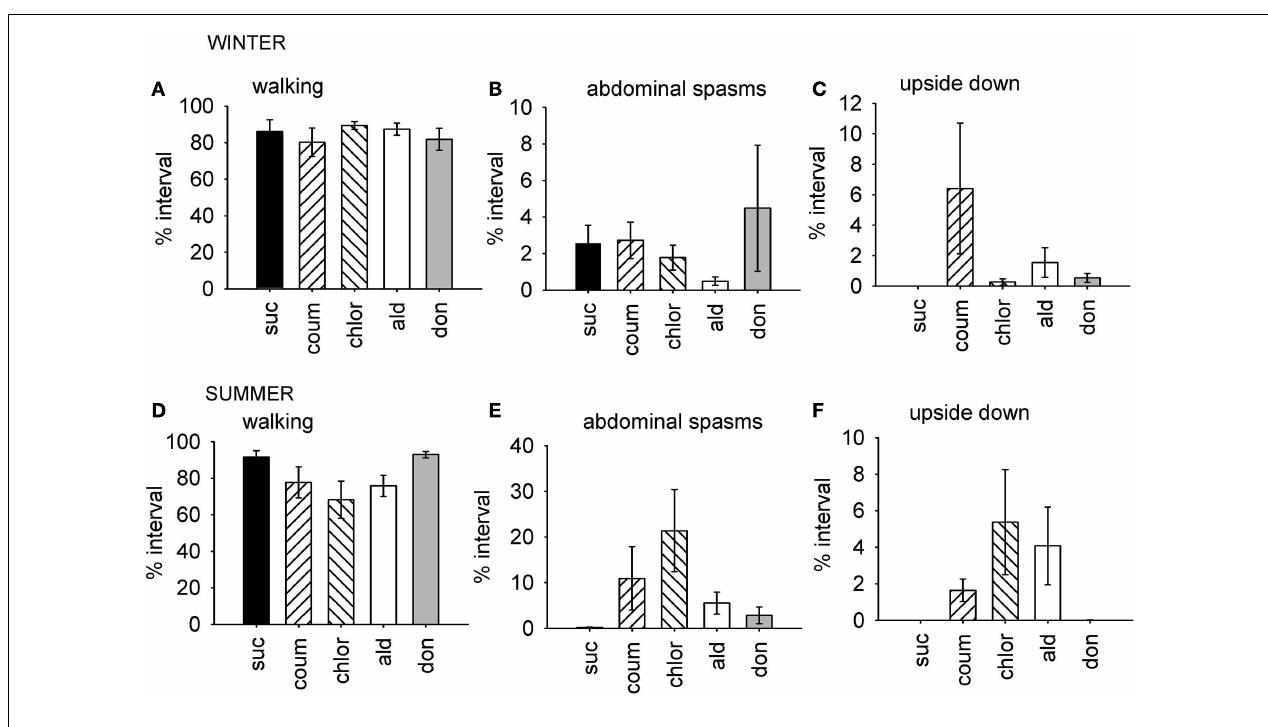
down, winter bees. (C) Abdominal spasms, winter bees. (D) Walking, summer bees. (E) Upside down, summer bees. (F) Abdominal spasms, summer bees. N ≥ 11 for each treatment group at each time of year. Suc, sucrose; Coum, coumaphos; Chlor, chlorpyrifos; Ald, aldicarb; Don,